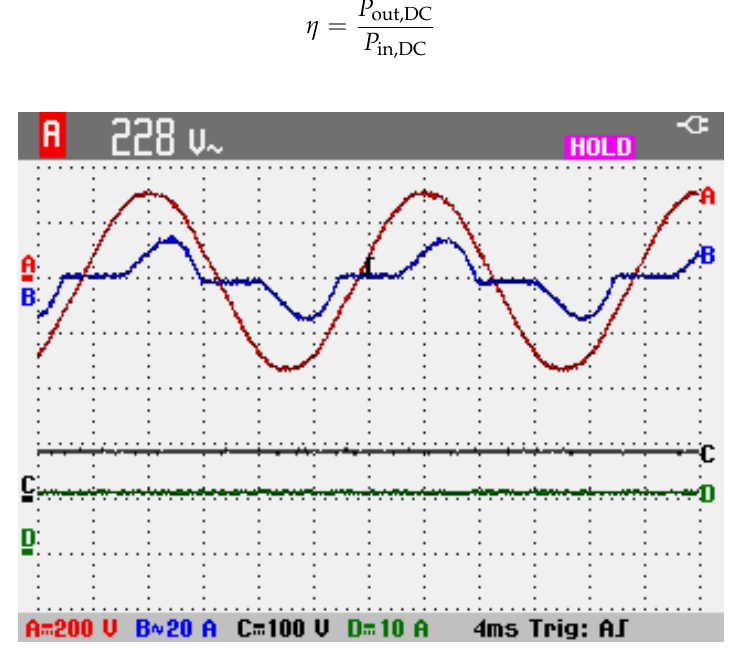
Figure 22. Oscilloscope screenshot for waveforms of the primary resonant voltage (A, magenta, 100 V/div), current (B, blue, 10 mV/A), secondary resonant voltage (C, black, 100 V/div), and current (D, green, 10mV/A) measurements for 1 kW output power and 150 V DC input.